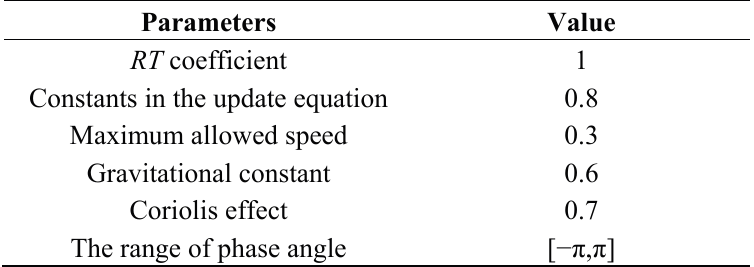
Table 1. The parameters setting of quantum wind driven optimization (QWDO).